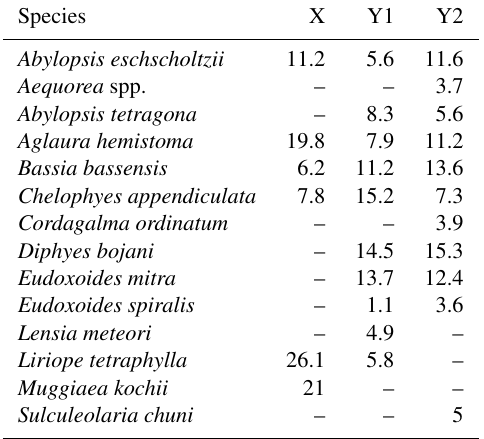
Table 2. Results of SIMPER analysis, showing the relative contri- bution of planktonic cnidarian species in the formation of the groups defined in the cluster analysis during autumn